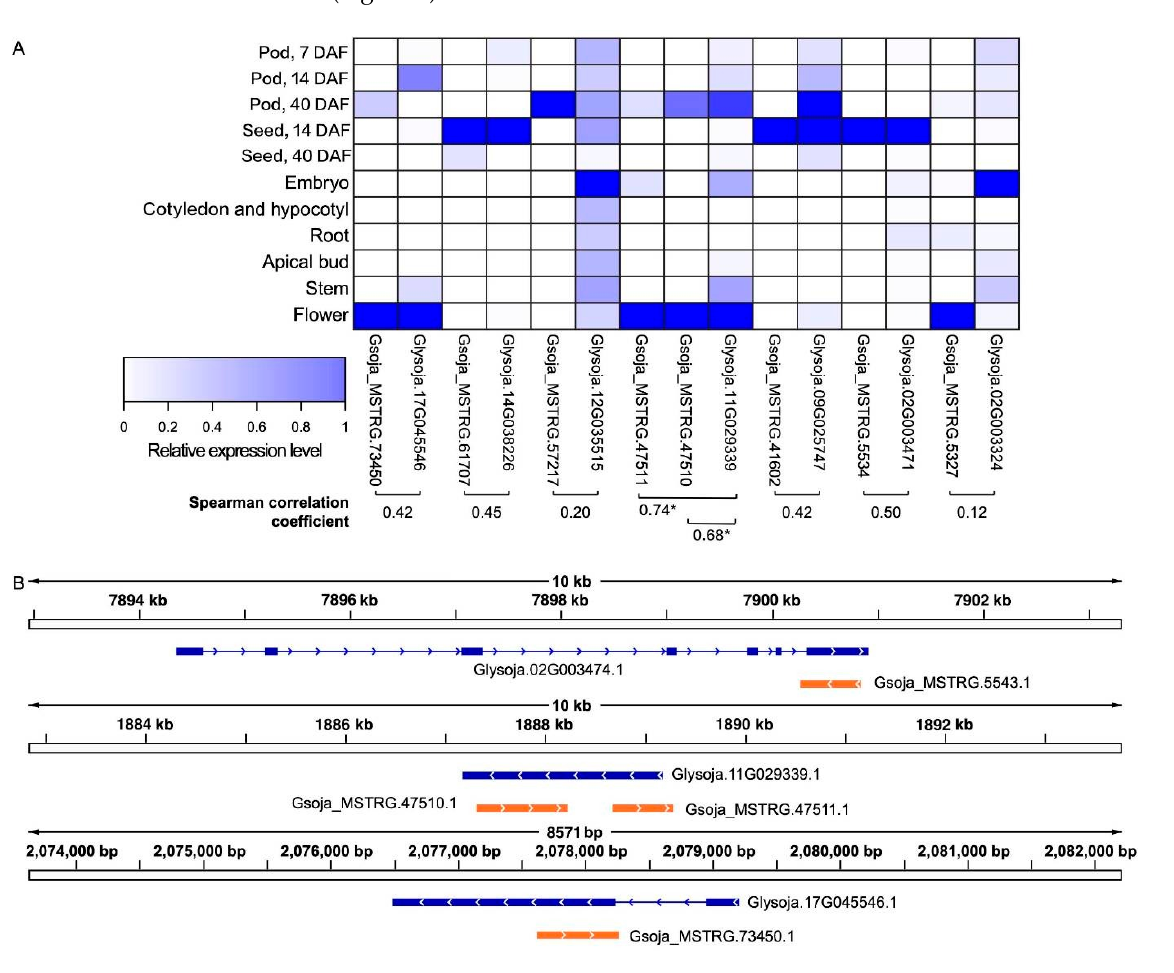
Figure 2. Antisense MATE transcripts and their sense counterparts in soybean accession W05 with positively correlated expression levels identified based on the publicly available RNA-seq datasets. Left panel. ( A ) A heatmap of the expression levels of the antisense-sense transcript pairs (joined by a square bracket) that are predicted to be correlated, with the corresponding Spearman correlation coefficients. *Gsoja_MSTRG.47510 and Gsoja_MSTRG.47511 are both antisense transcripts corresponding to the sense transcript Glysoja.11G029339, with the Spearman correlation coefficients being 0.68 and 0.74 respectively; ( B ) the genomic locations of three of the antisense-sense transcript pairs having high Spearman correlation coefficients are showcased.